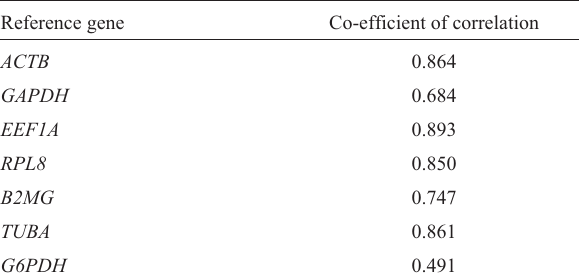
Table 5 - The stability of reference genes tested by